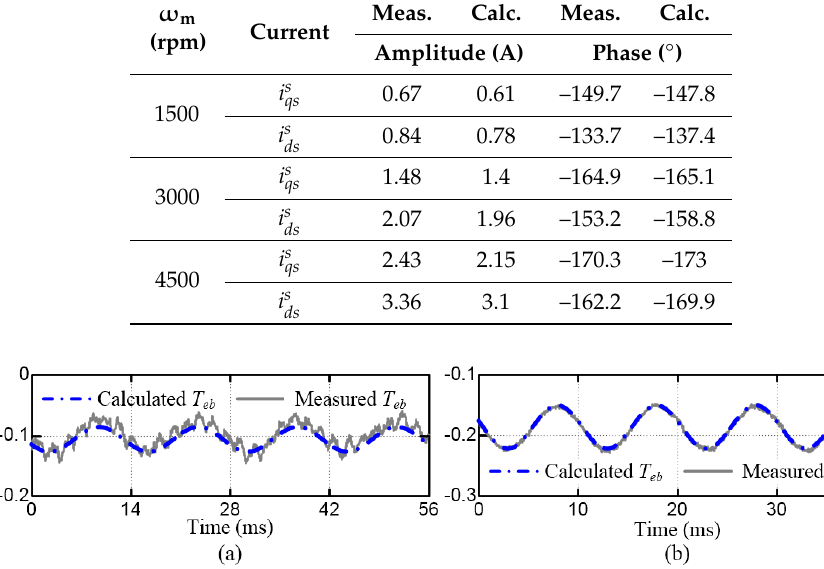
Figure 12. Comparison of the measured and calculated braking torque at ( a ) 1800 rpm and ( b ) 1500 rpm.